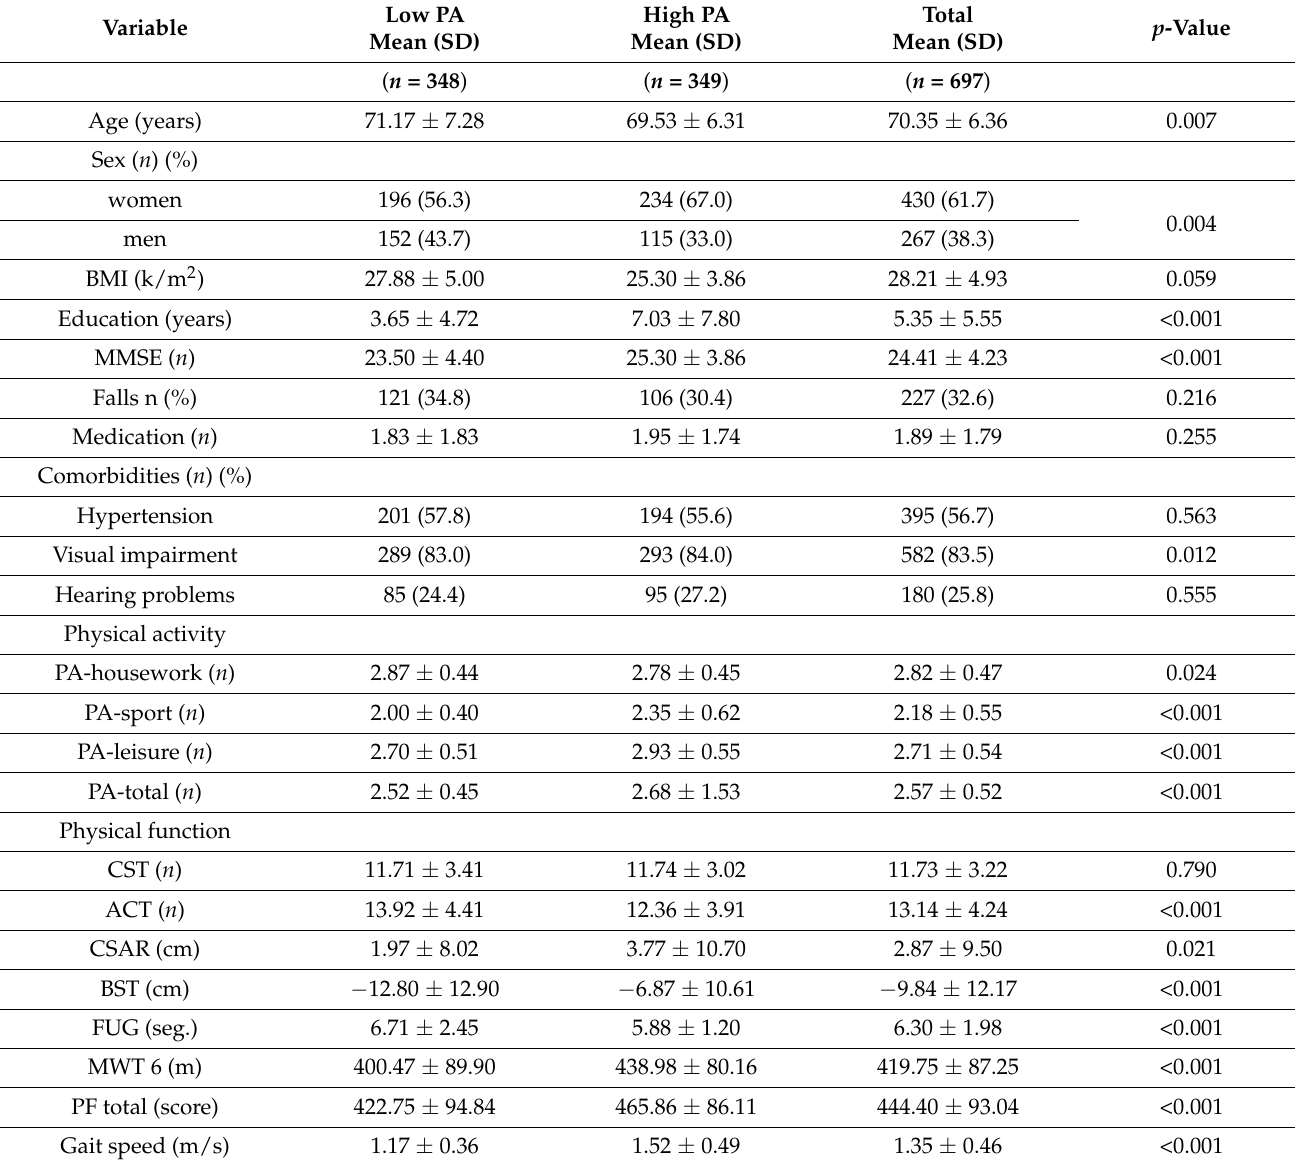
Table 1. Main characteristics of participants, according to the level of physical